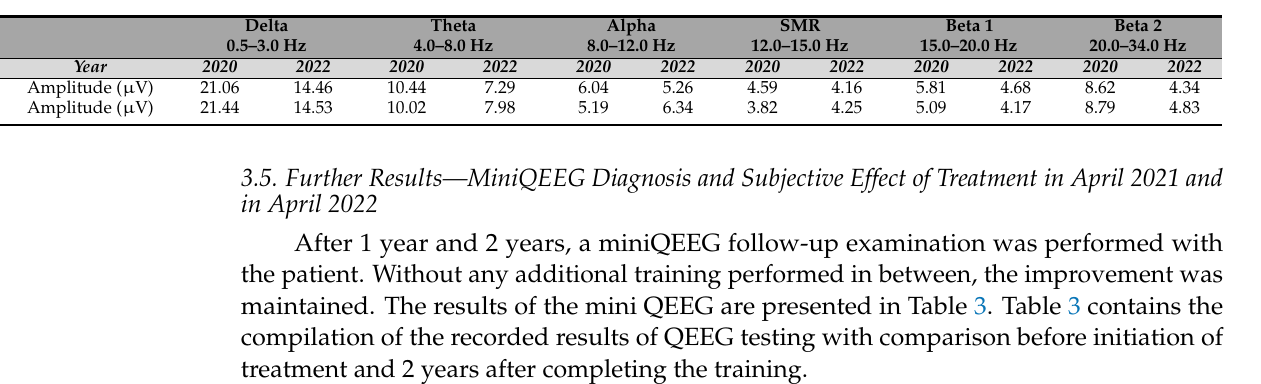
Table 3. Comparison of QEEG results from April 2020 (before neurofeedback treatment) and from April 2022 (2 years after completing the neurofeedback treatment). Channel